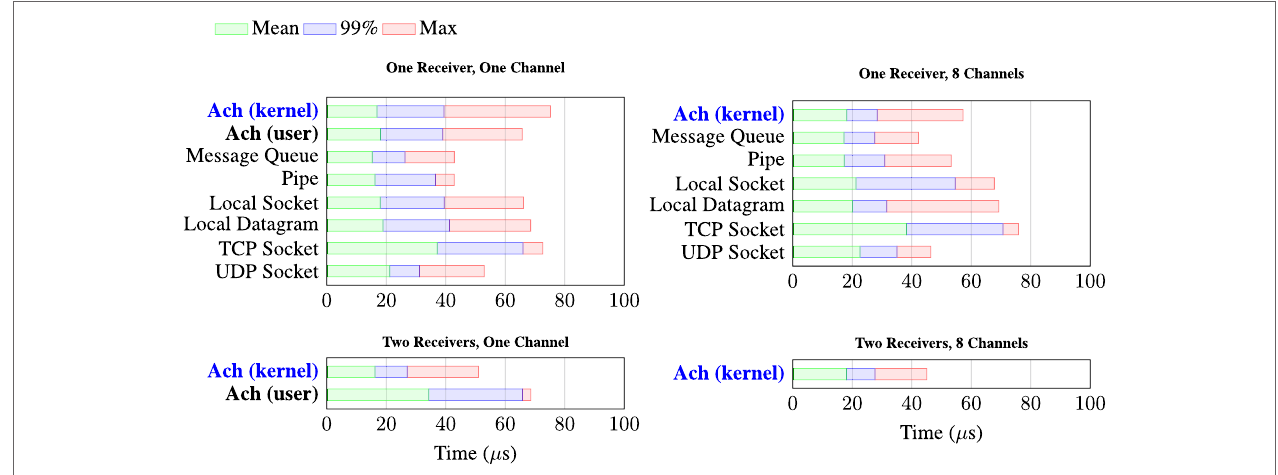
FigUre 3 | Message latency for ach and POsiX communication . Ach has comparable performance to optimized POSIX communication, and unlike POSIX methods, Ach enables multiple receivers and prioritizes newer data. In the plots, “Mean” is the average latency over all messages, “99%” is the latency that 99% of messages beat, and “Max” is the maximum recorded latency. The long-tail of the worst-case behavior arises from the focus of general purpose platforms on average-case performance instead of bounded response needed by real-time systems. For example, lazy algorithms and hardware memory caches improve average performance, but still leave the worst-case cost to